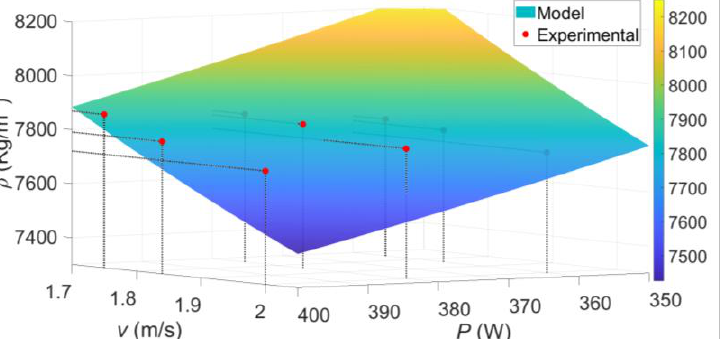
Figure 7. Experimental and predicted samples’ density graph as a function of laser power and scan velocity. It is observed that the best densification conditions are obtained at lower scanning speeds and small laser power. Low scanning speed implies larger exposure time of the laser in the powder bed which increases sample densification. When the laser power supply is improperly set, it creates undesirable effects such as particle sublimation or ejection, which leads to metallic samples with higher porosity.